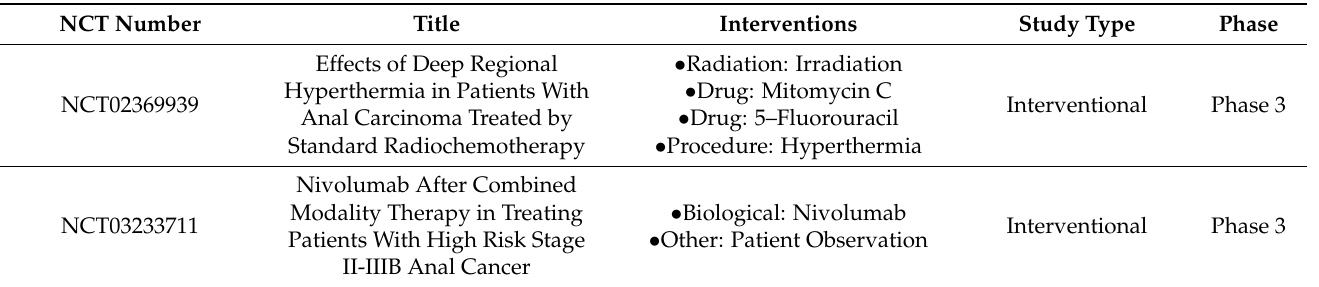
Table 4. Current Clinical Trials in prevention and treatment of anal